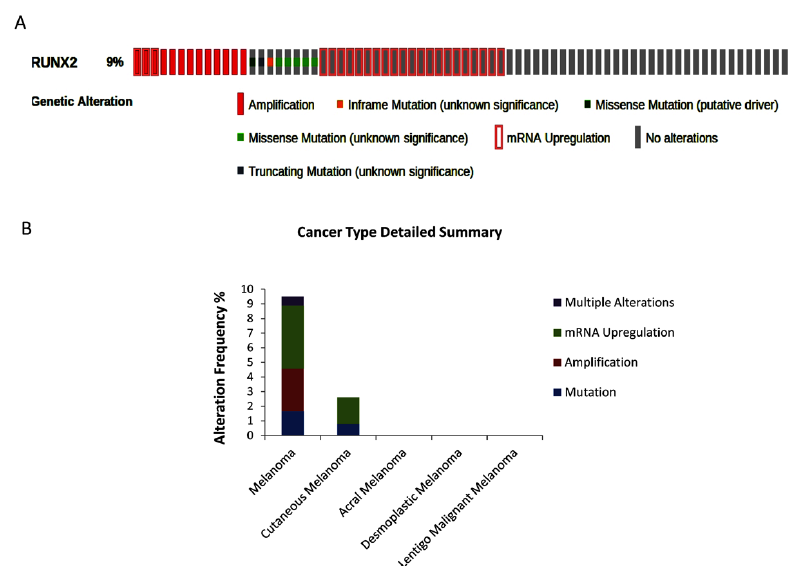
Figure 1. Genomic alterations in TCGA samples of patients affected by Skin Cutaneous Melanoma (SCKM). OncoPrint: graphical summary of genomic alterations in RUNX2 detected in 42 of 478 samples. A: the figure shows the samples with alterations ( A ); Distribution of alteration frequency in RUNX2 : mRNA upregulation: 4.39%, gene amplification: 2.09%, mutation: 1.67%, and, finally, multiple alterations (0.63%) ( B ).